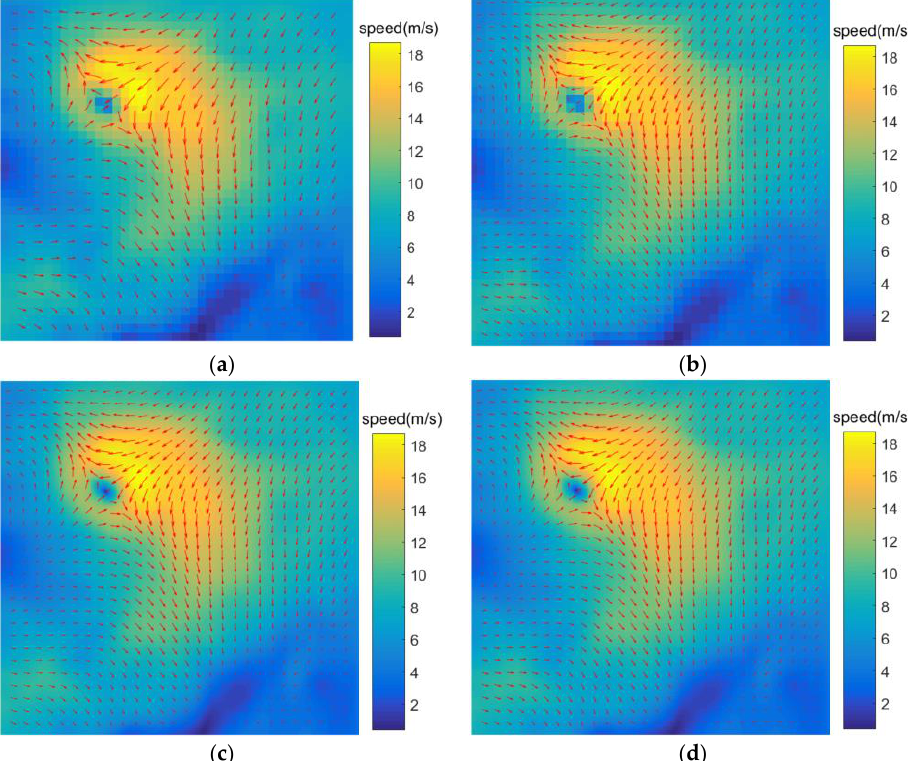
Figure 8. ( a ) Original wind data rendering result; ( b ) nearest neighbor interpolation result; ( c ) cubic spline interpolation result; ( d ) bilinear interpolation result.